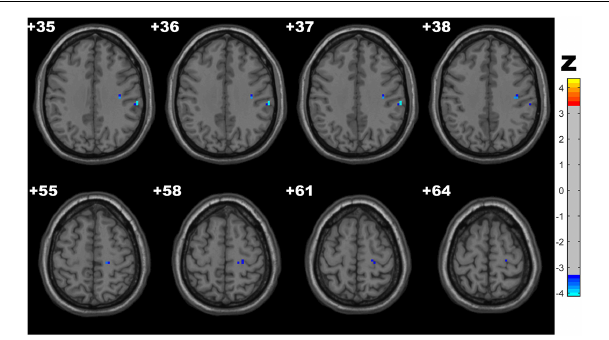
FIGURE 2 | Clusters with significantly altered fALFF values among groups (ANOVA and LSD post hoc test with GRF correction, voxel-level p < 0.001, cluster-level p < 0.05). The blue areas denote lower fALFF values in the CSVD-c group than in the control